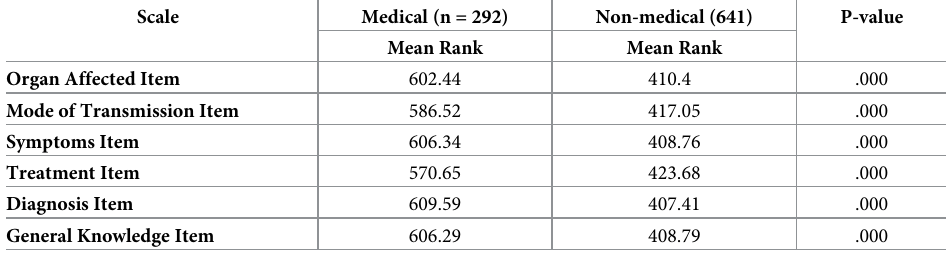
Table 4. Mann-Whitney test analysis of medical vs non-medical sources of information regarding the questioned items.